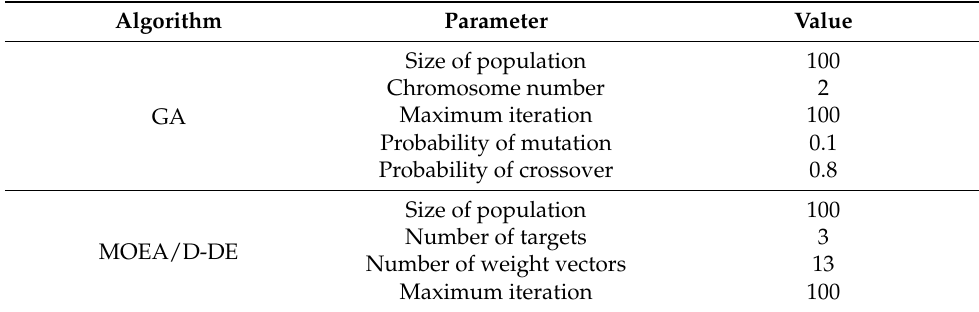
Table 4. Parameter setting of GA and